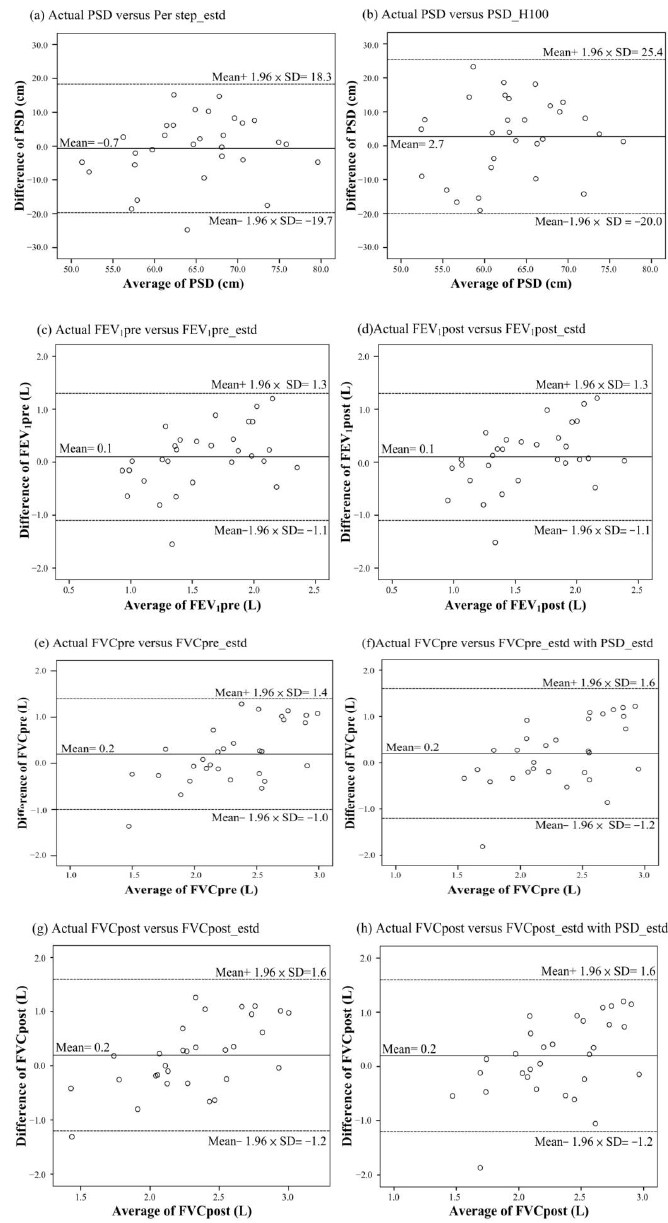
Figure 4. Bland–Altman plot between predictions and actual value. ( a ) Actual PSD versus PSD_estd; ( b ) Actual PSD versus PSD_H100; ( c ) Actual FEV 1 pre versus FEV 1 pre_estd; ( d )Actual FEV 1 post versus FEV 1 post_estd; ( e ) Actual FVCpre versus FVCpre_estd; ( f ) Actual FVCpre versus FVCpre_estd with PSD_estd; ( g ) Actual FVCpost versus FVCpost_estd; ( h ) Actual FVCpost versus FVCpost_estd with